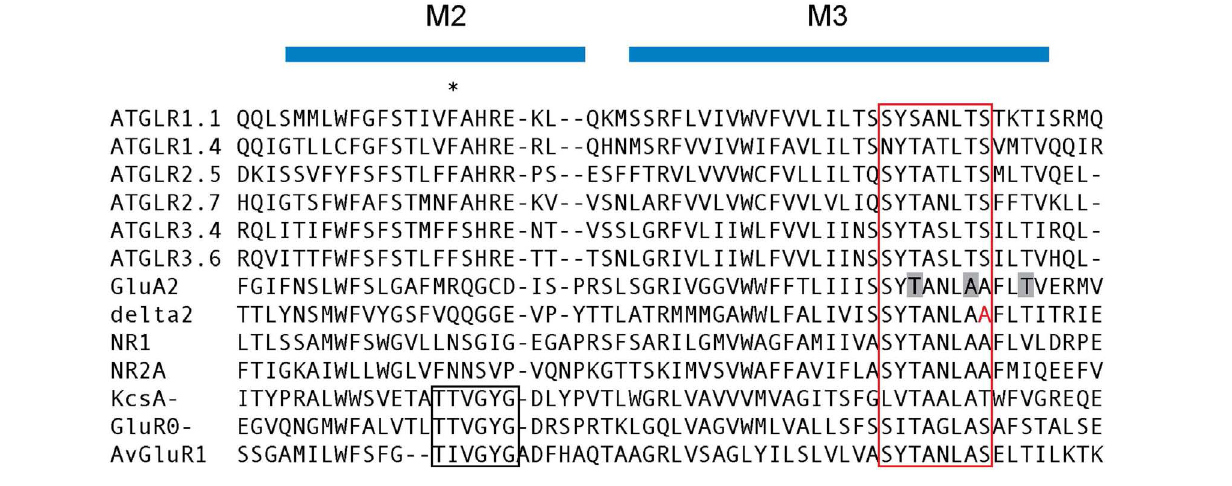
FIGURE 4 |An alignment of the regions consisting of the selectivity filter and the constrictive domain [the end of M2 (P-loop) and M3 region, respectively]. The Q/R/N site of mammalian glutamate receptors is marked with an asterisk.The SYTANLAA motif conserved among glutamate receptors is marked in red box. Residues that form the constrictive portion of GluA2 channel is marked with gray.The “lurcher” residue in δ 2 is marked in red.The TXVGYG motif in the potassium channel KcsA, GluR0, and AvGluR1 is also